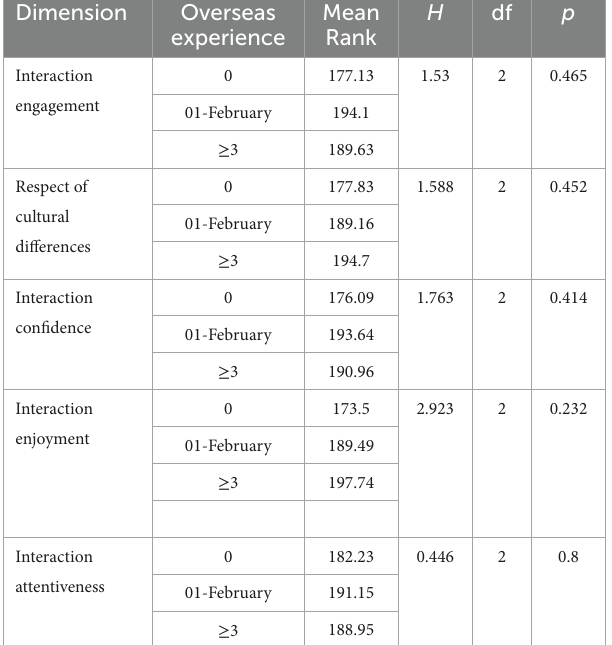
TABLE 8 Kruskal-Wallis H test for different dimensions according to overseas experience.